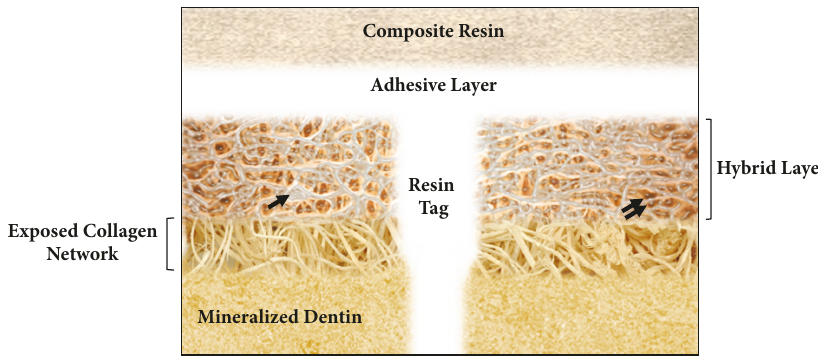
Figure 5: S c h ematic illustration o f t h e instability o f t h e h ybrid layer . Apatite crystals are removed from dental hard tissues with